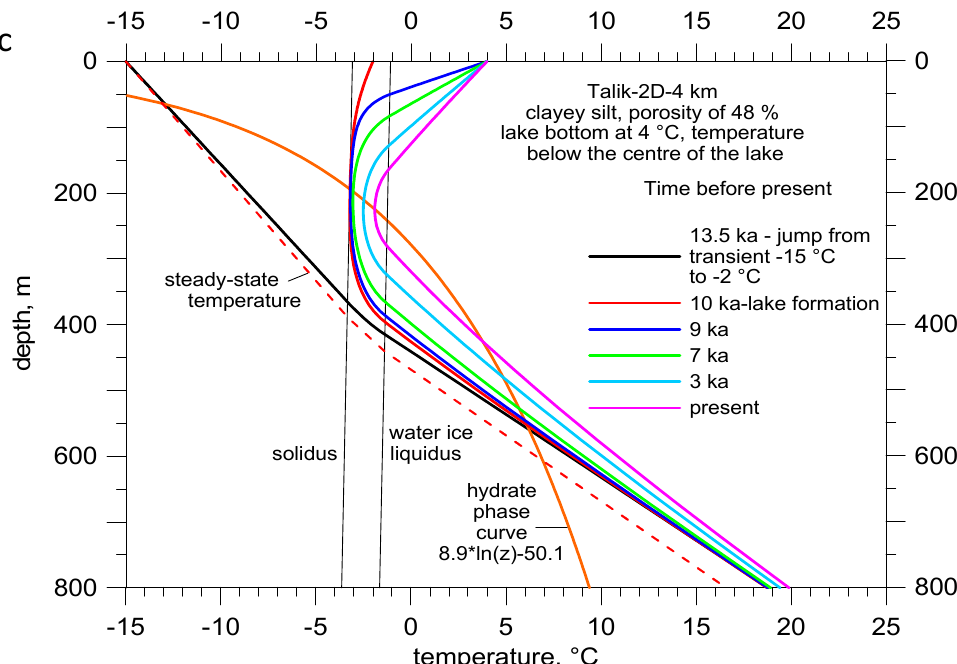
Figure 12. Computed T – z profiles below the center of the lake using the transient initial profile for a 10 ka lake with a width of 4 km and a bottom temperature of 4 °C at 9 ka ago, 7 ka ago, 3 ka ago, for clayey silt lithology with porosities of 30% ( a ), 40% ( b ), 48% ( c ).